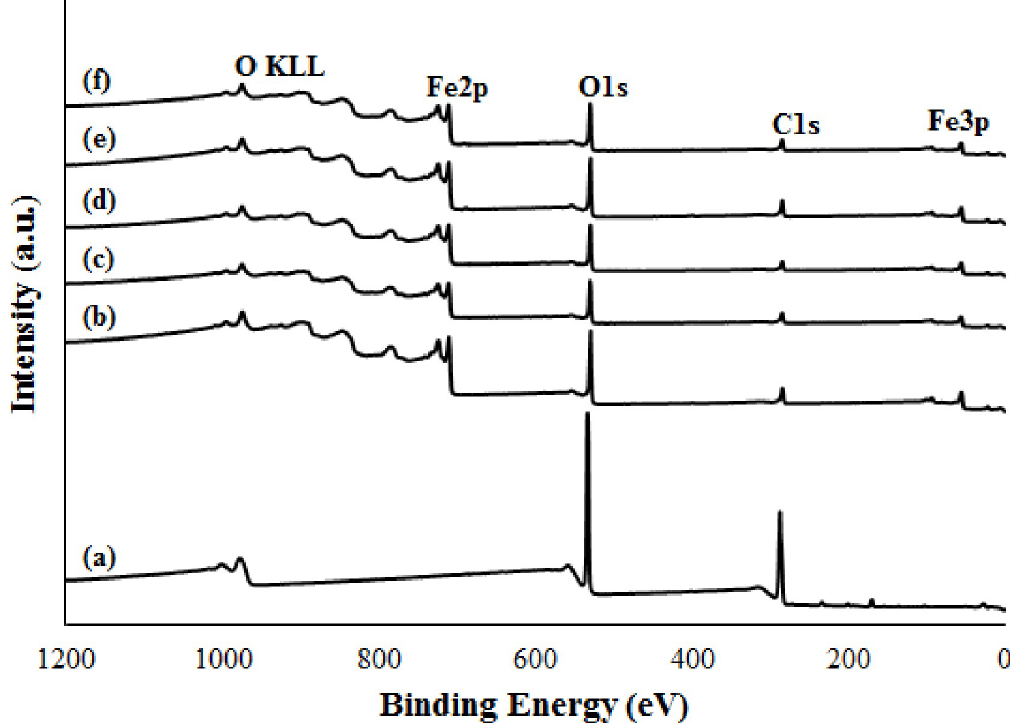
Fig 5. XPS survey spectra of (a) GO, (b) M-rGO3, (c) M-rGO6, (d) M-rGO12, (e) M-rGO18 and (f)